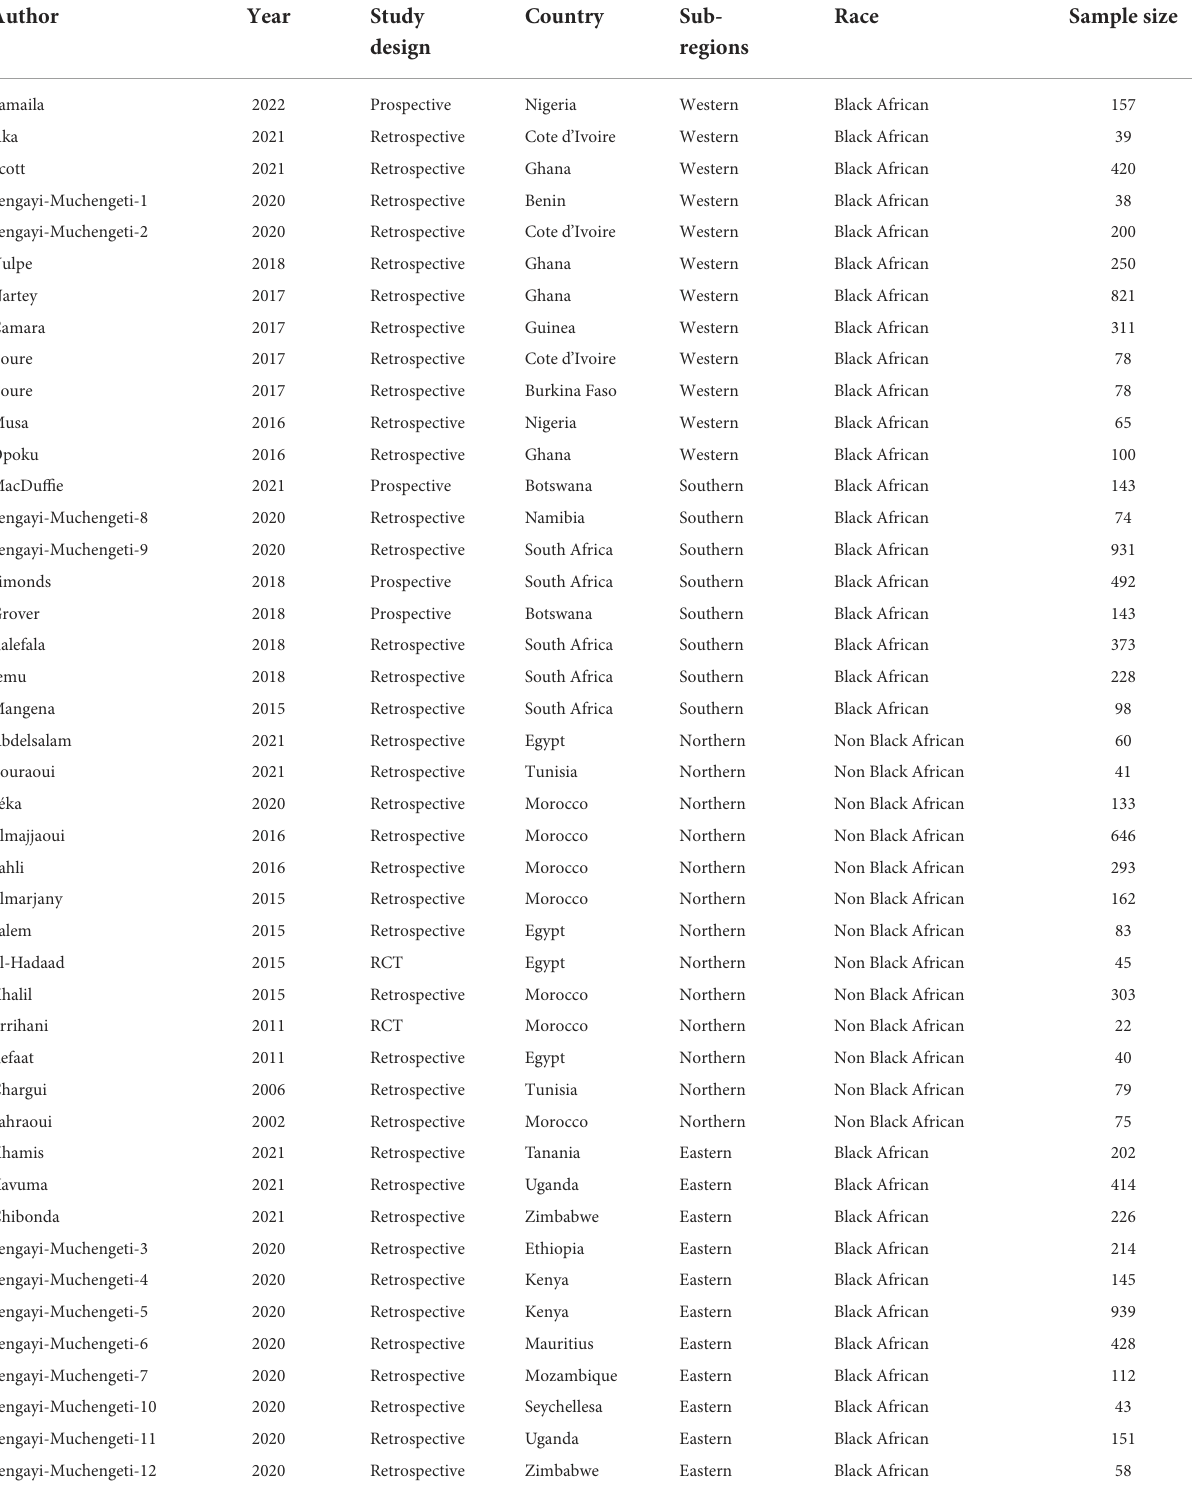
TABLE 2 Characteristics of the selected